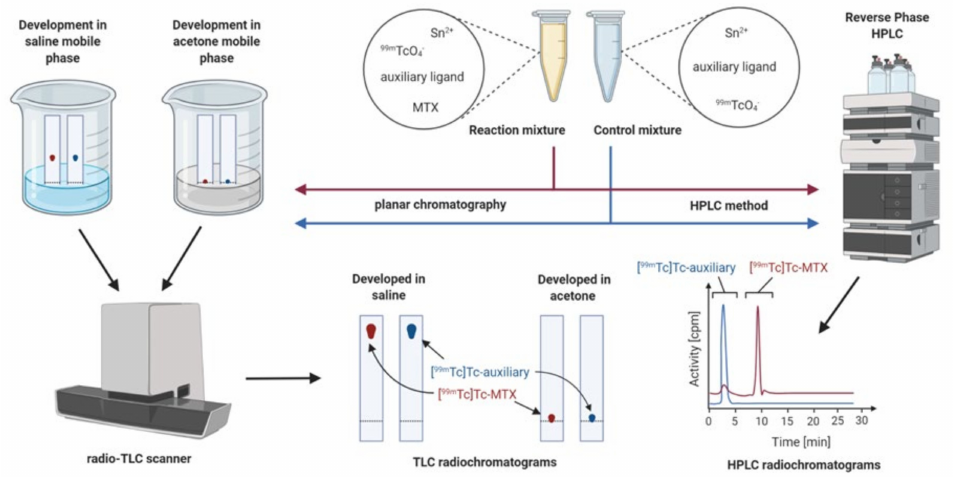
Figure 9. Schematic protocol of ITLC and HPLC comparative analyses executed within own studies on MTX labelling with 99m